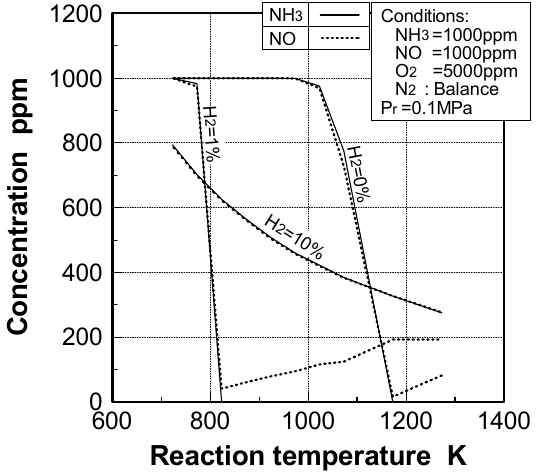
Figure 41. Effect of H concentration on the temperature window as defined by 2